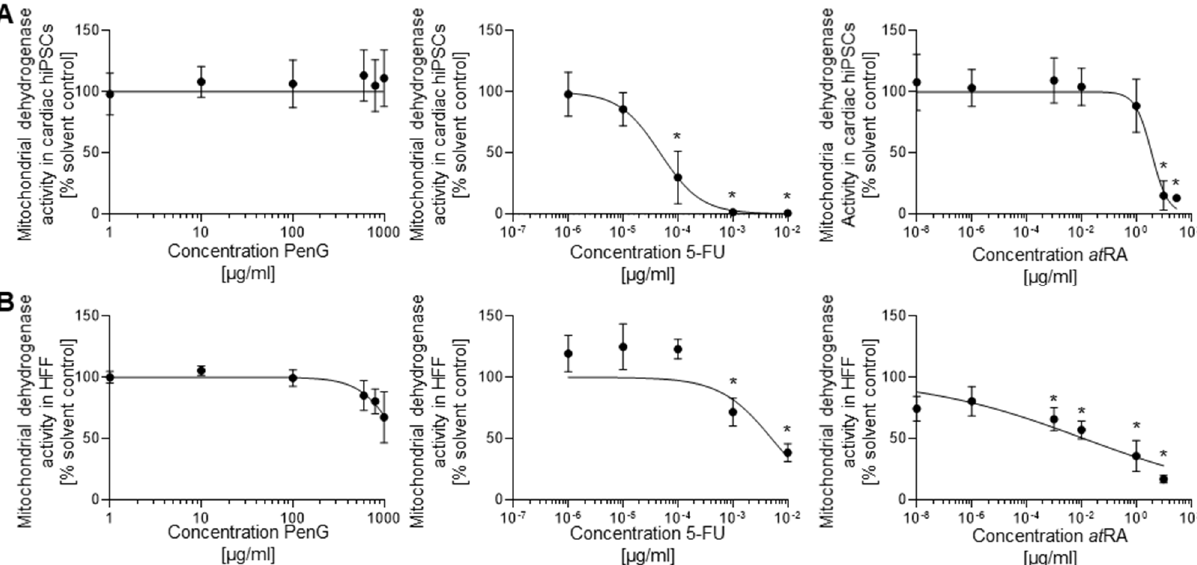
Figure 4. 5-FU and at RA treatment reduced hiPSC-cardiomyocyte and hFF viability in a dose-dependent manner as assessed via MTT assay. ( A ) hiPSC viability screens for 5-FU, at RA, and PenG, n = 3 biological replicates ± SD. *: p < 0.05 = the lowest concentration significantly below the untreated hiPSC control group as determined by One-Way ANOVA. ( B ) hFF viability screens for 5-FU, at RA, and PenG, n = 3 biological replicates ± SD. *: p < 0.05 = the lowest concentration significantly below the untreated hFF control group as determined by One-Way ANOVA. hiPSC, human induced pluripotent stem cell; MTT, mitochondrial dehydrogenase activity assay; 5-FU, 5-fluorouracil; at RA, all-trans retinoic acid; PenG, penicillin G; hFF, human foreskin fibroblast.